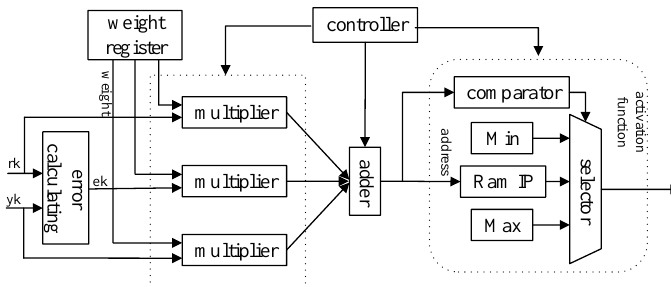
Figure 8. Hardware circuit design of single neuron.